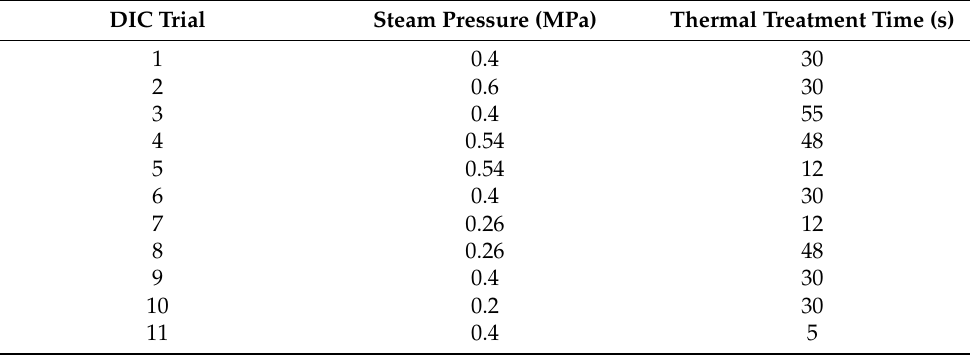
Figure 4. Five-level central rotatable experimental design, with steam pressure “P” and heat treatment time “t” as DIC operating parameters. Table 1. Applied experimental design of selected DIC processing parameters.